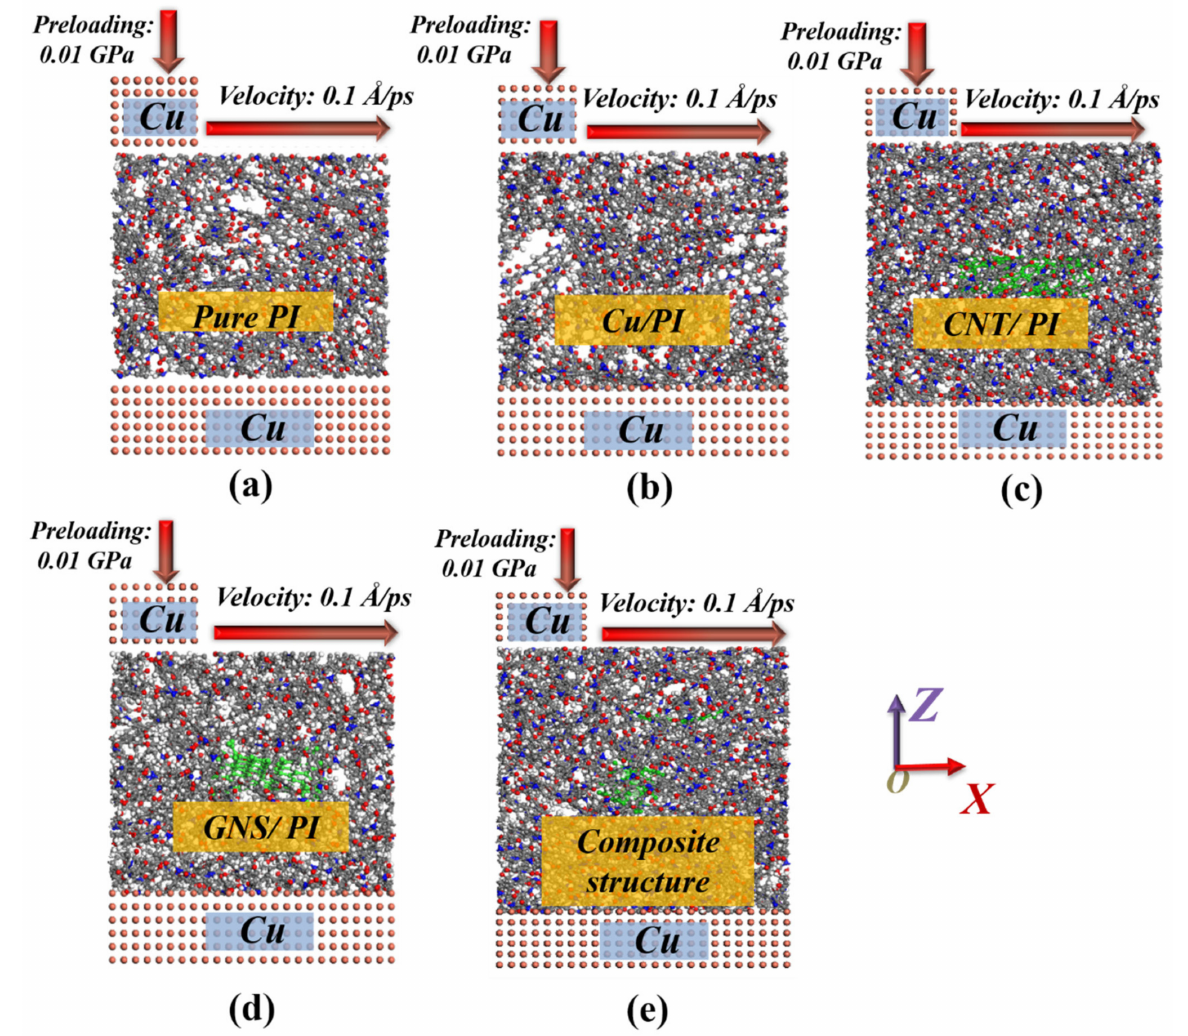
Figure 4. Friction pair model of the ( a ) PI, ( b ) Cu/PI, ( c ) CNT/PI, ( d ) GNS/PI, and ( e ) compos- ite